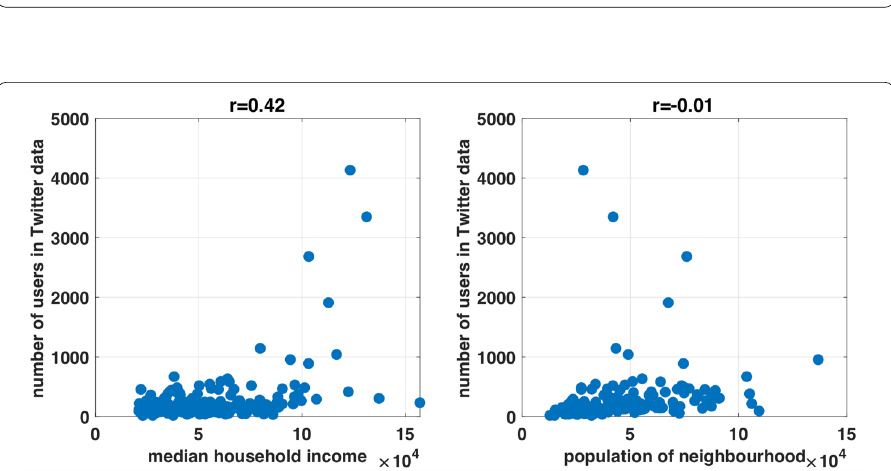
Figure 7 The relationship between the number of users in the Twitter data set and the neighborhood-level wealth, for the Northern American metropolitan area